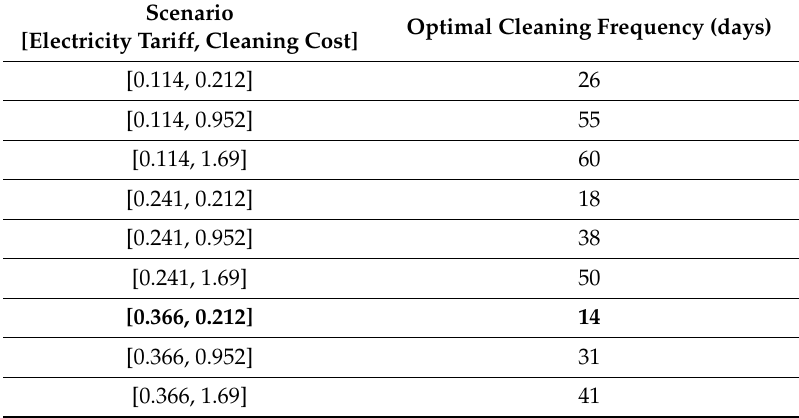
Table 4. Optimal cleaning frequency of each